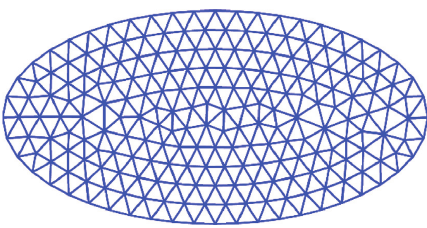
Figure 12: Domain